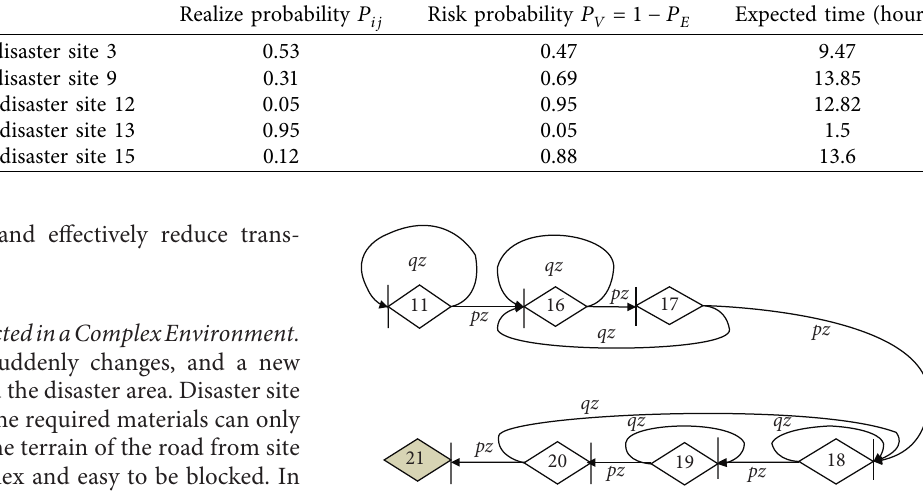
Figure 2: Random network diagram for